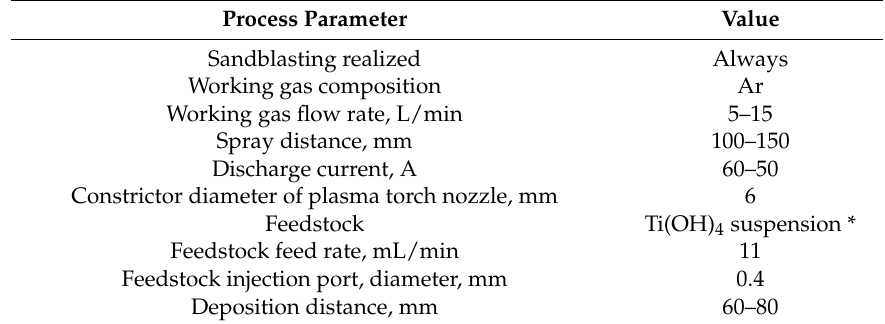
Table 1. Suspension plasma spray parameters used to deposit the TiO 2 coatings in this study.